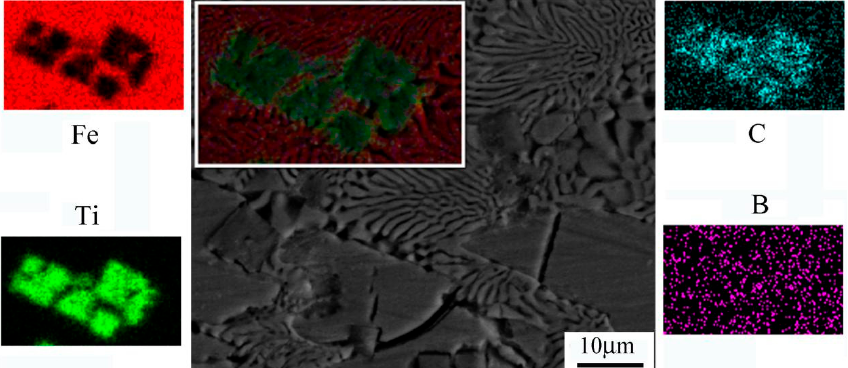
Figure 5. SEM image and EDS element distribution maps of the hardfacing layers with 6.85% B addition.